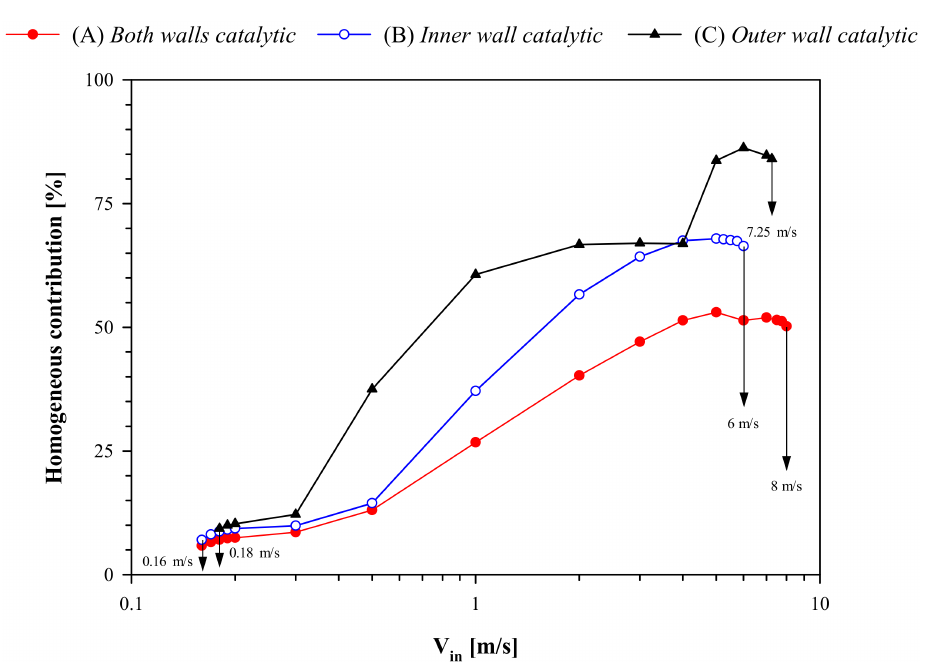
Figure 7. Homogeneous contribution to the conversion of propane (Equation (1)) as a function of V in for the three reactor configurations of Figure 1 with different catalyst placement. Low thermal conductivity (3 W/(m K)). Arrows indicate extinction (at low values of V in ) and blowout (at high values of V in